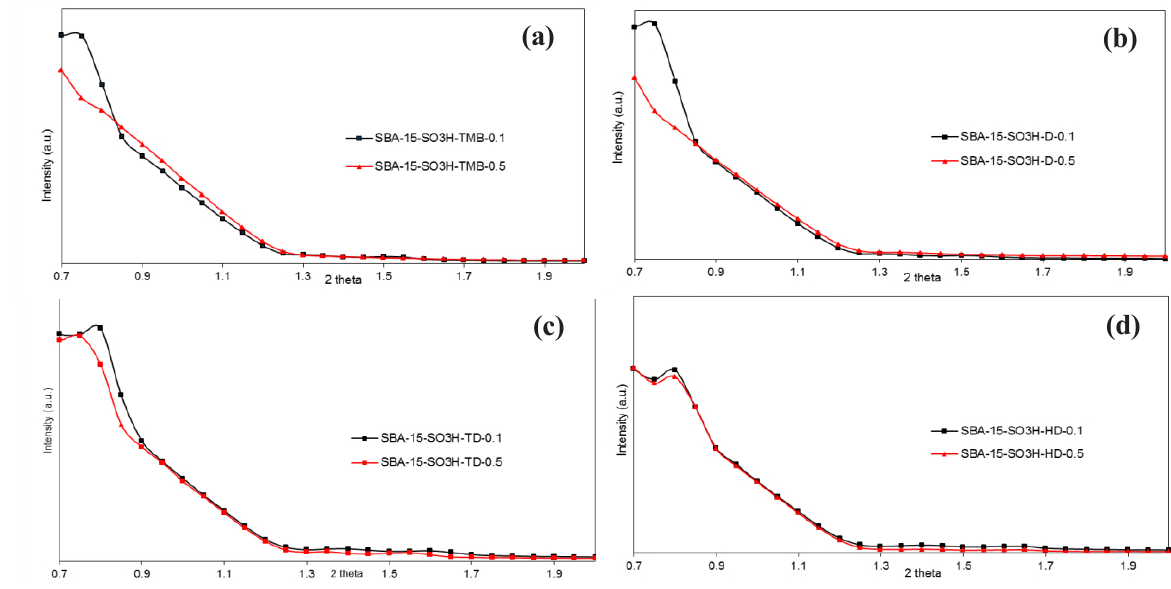
Figure 2: XRD patterns of SBA-15-SO H-TD-0.1 and SBA-15-SO 3 H-D-0.5 (b), SBA-15-SO 3 HD-0.5.